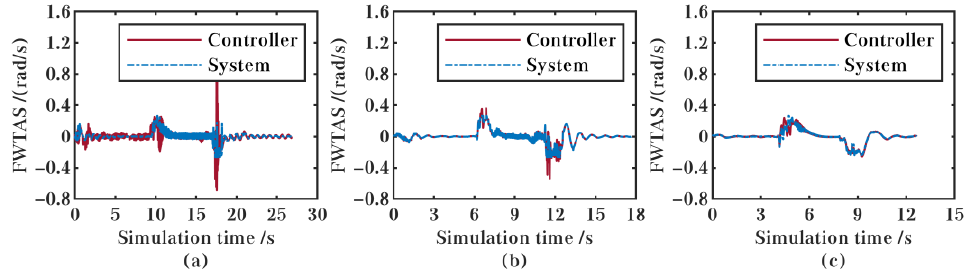
Figure 12. The front wheel turning angle speed of the simulation at different speeds: ( a ) at 2 m/s; ( b ) at 3 m/s; ( c ) at 4 m/s.